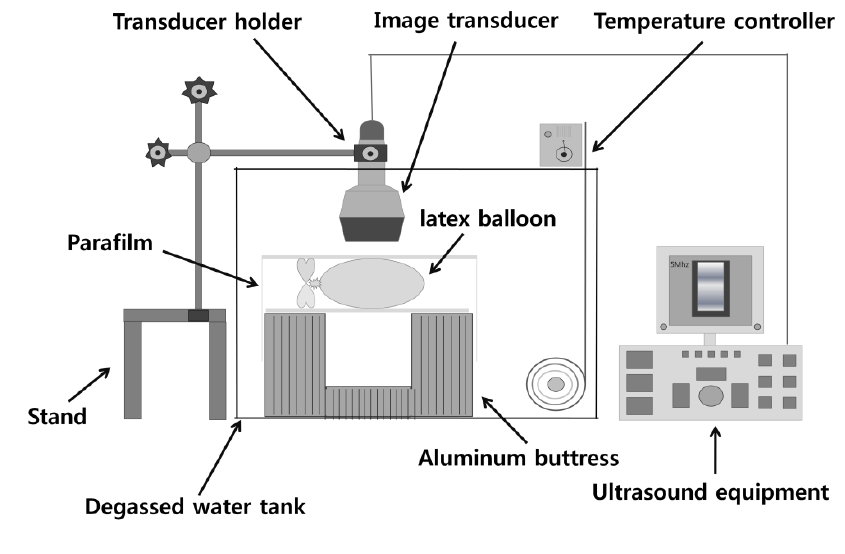
Figure 12. Experiment setup for UCA response to an ultrasound imaging system. All